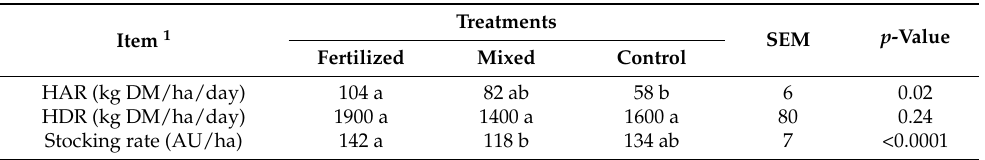
Table 3. Herbage accumulation rate and stocking rate of palisade grass pastures fertilized with urea (150 kg N/ha/year), mixed with pintoi peanut (mixed), and non-fertilized (control). Average of 2 years of evaluation of 5 grazing cycles ( n =